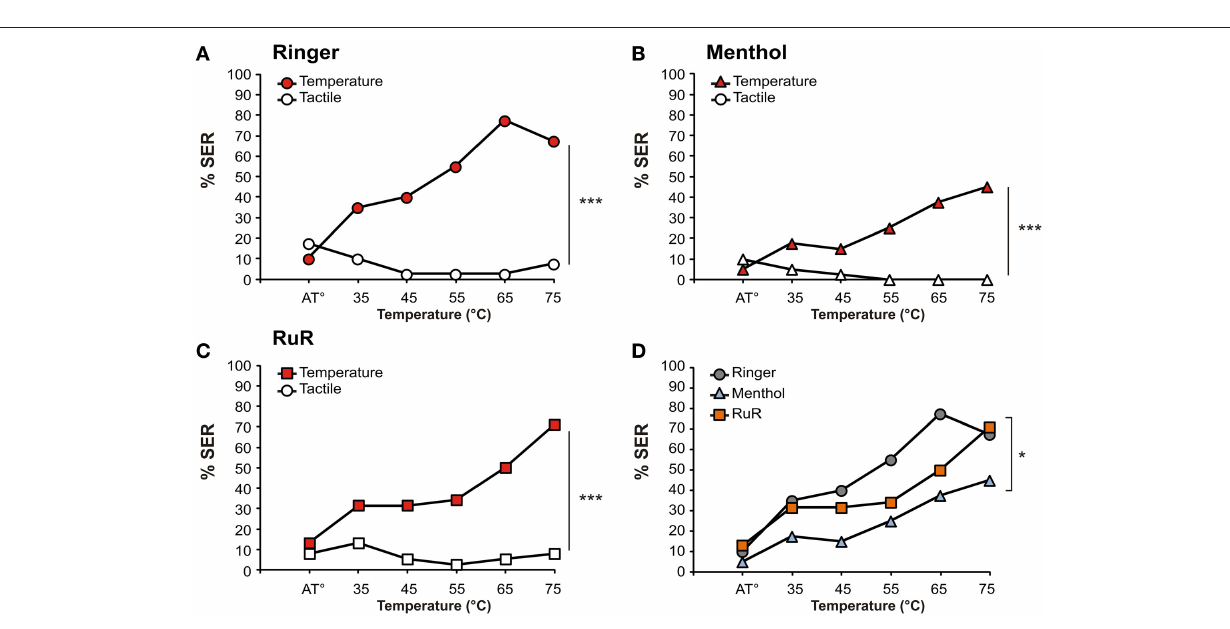
2.03, p < 0.05). In particular, weaker responses were observed